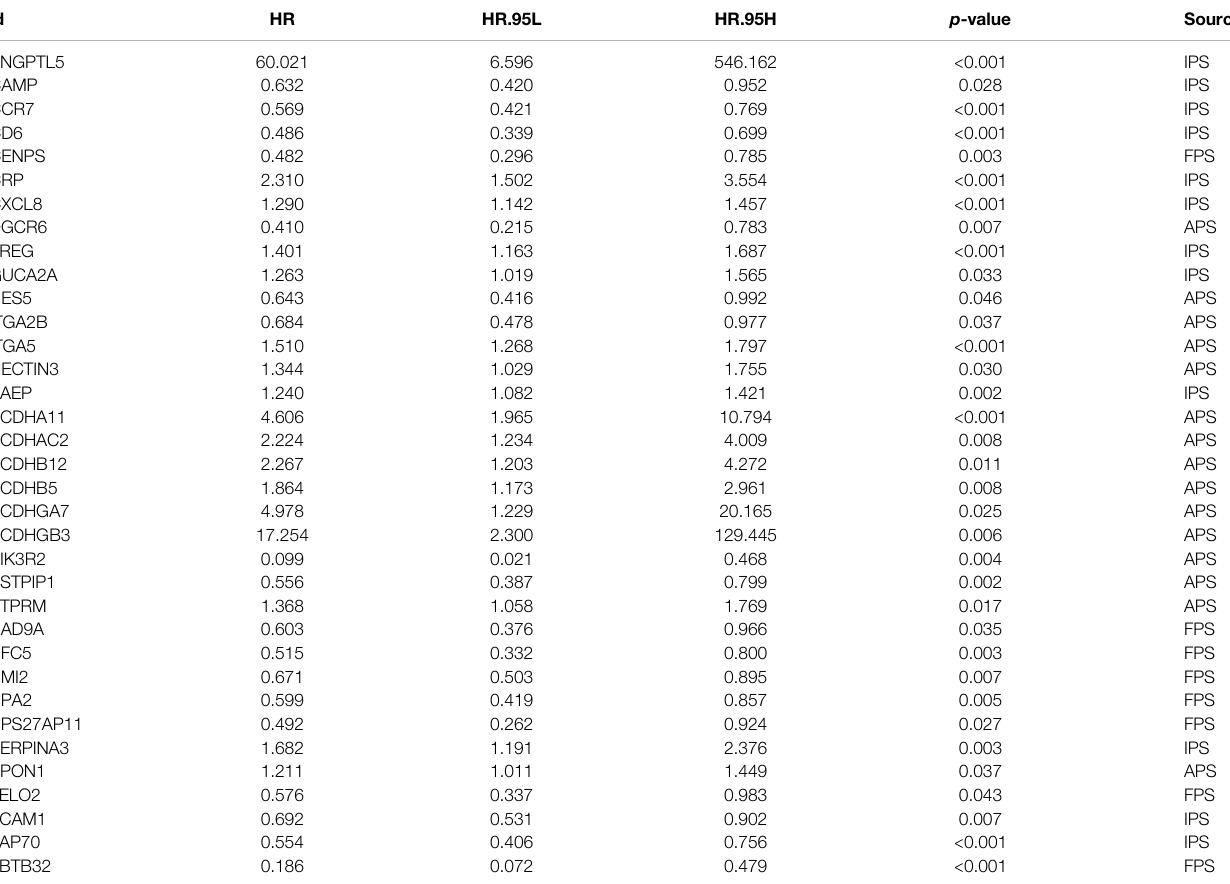
TABLE 4 | Signi fi cant genes screened out by univariable cox regression analysis for CPS model fi tting.